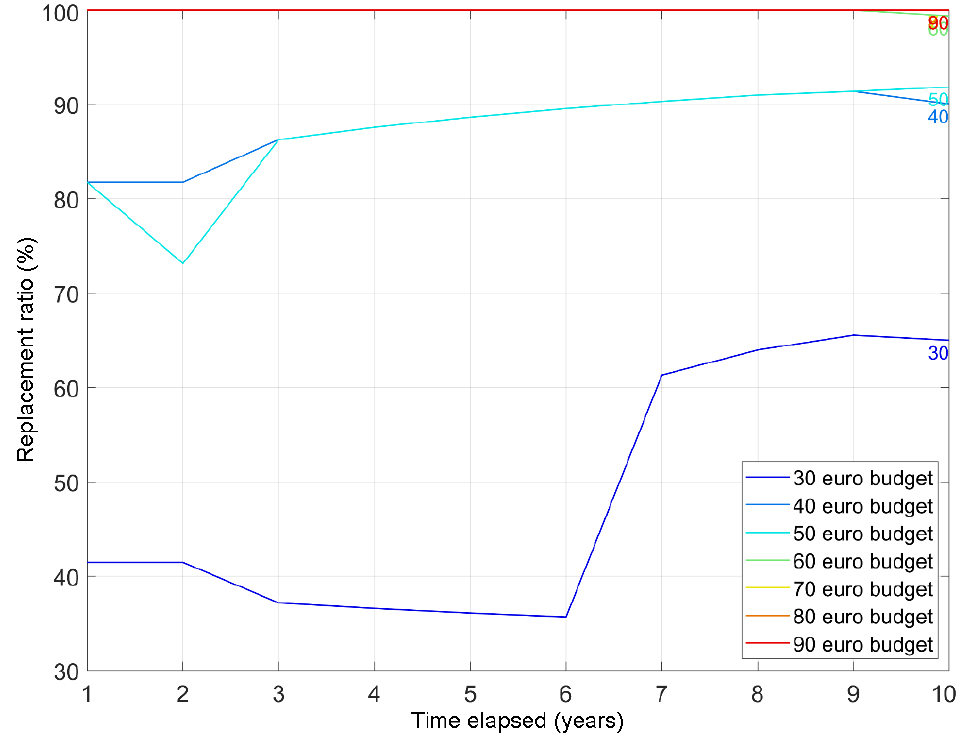
Figure 8. Replacement ratio % versus time elapsed for a dishwasher’s PCB.